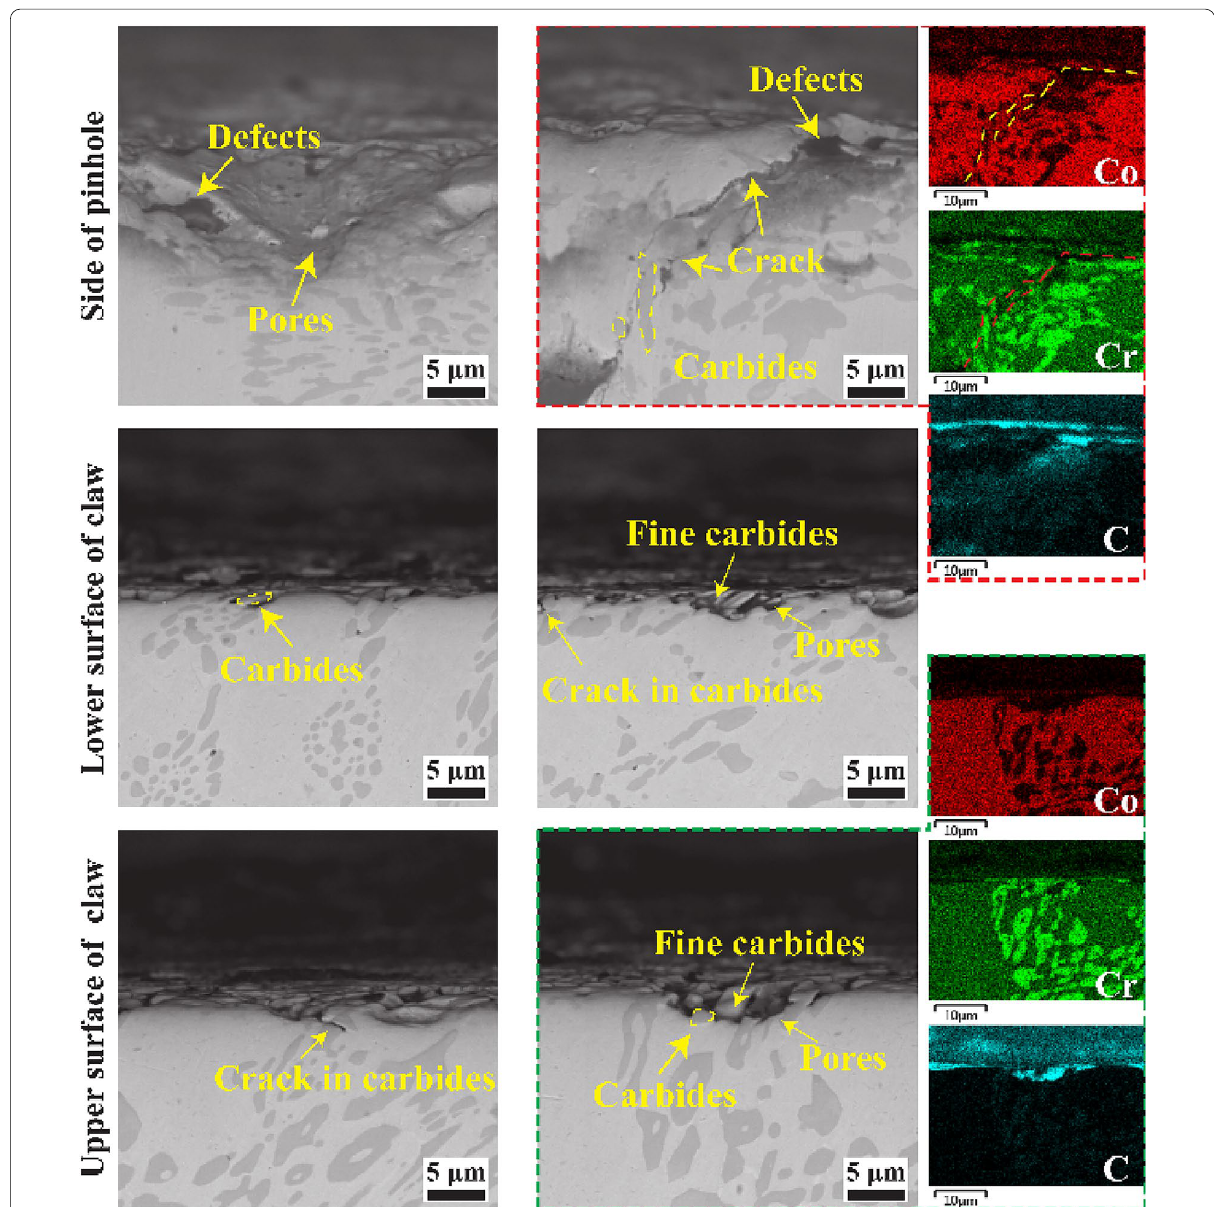
Figure 13 Cross-sectional morphologies of movable latch in various